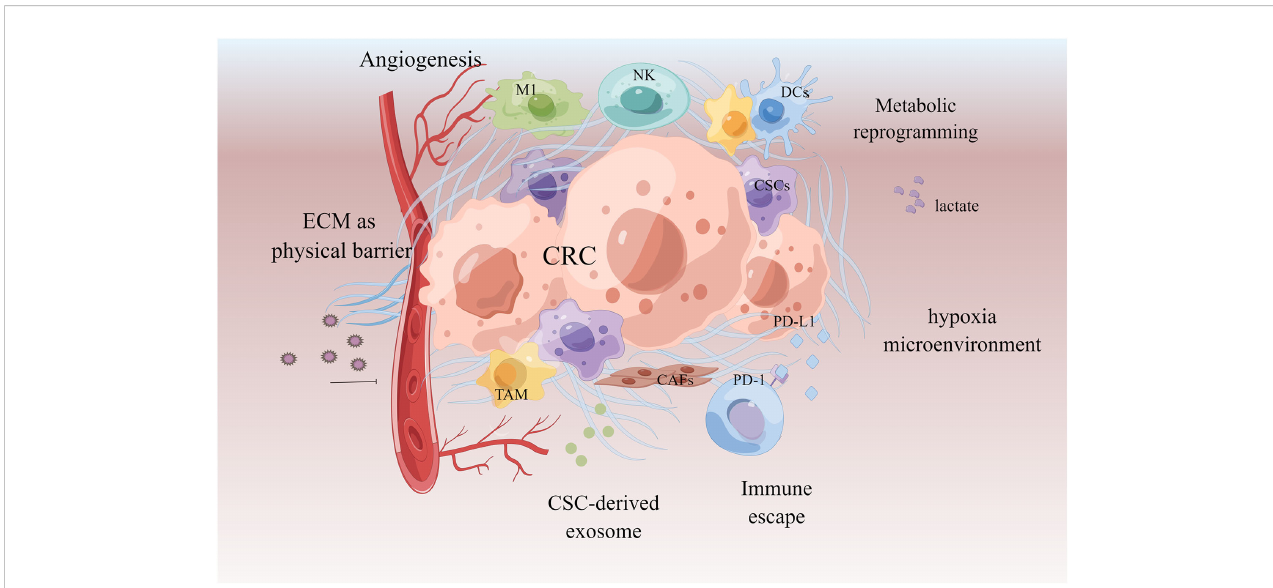
FIGURE 6 Tumor microenvironment in chemoresistant CRC. Extracellular matrix acts as a physical barrier to prevent drugs from entering. The microenvironment of the formation of new blood vessels, hypoxia and acidi fi cation contributes to chemoresistance. Cancer-associated fi broblasts (CAFs) and cancer stem cells (CSCs) promote tumor by secreting tumor growth factors and exosomes. Immune cells acquire immunosuppressive phenotype to make the tumor